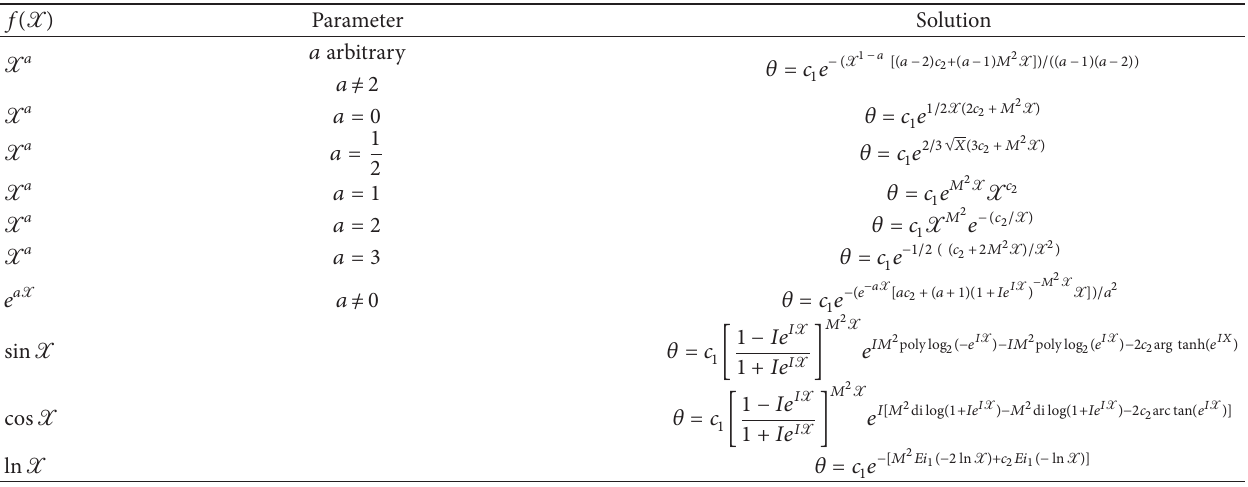
Table 6: Modified general solution for 𝑓( X ) where X = 𝑥 + 1 and 𝑚 = 𝑛 = −1